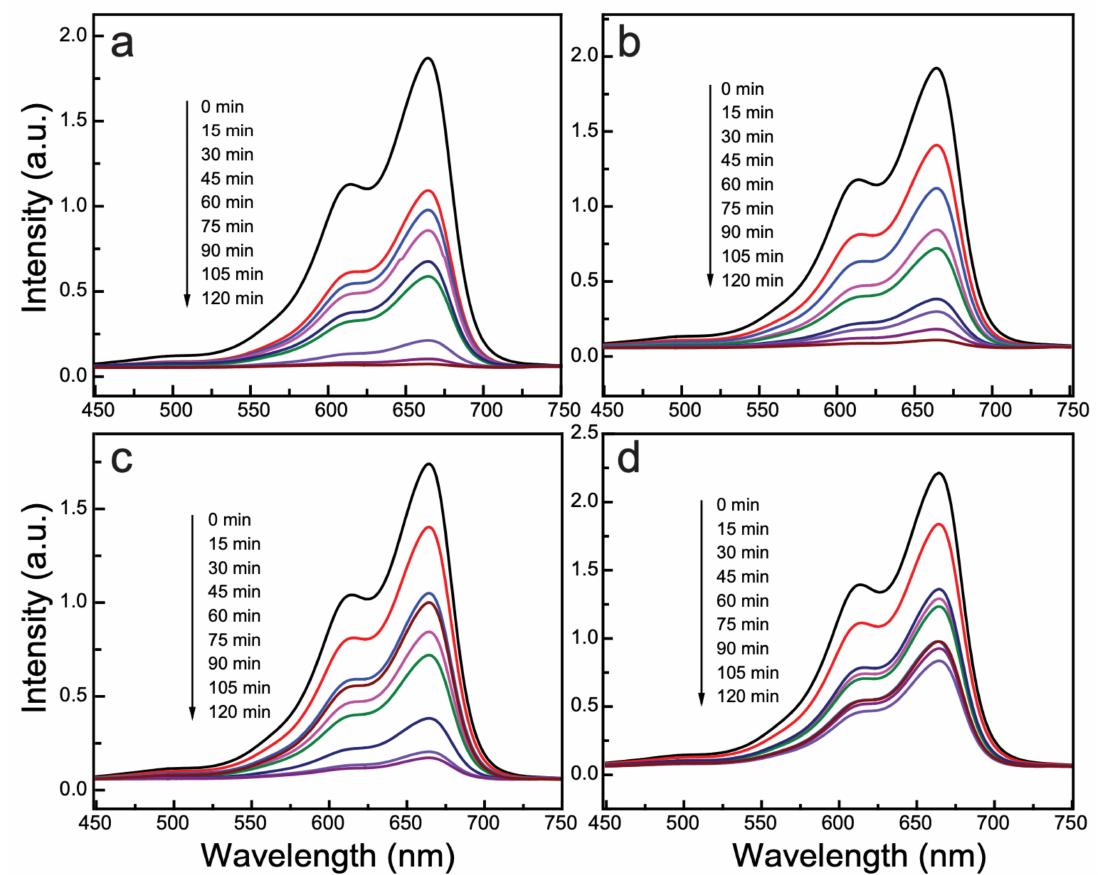
Figure 6. Photodegradation of the methylene blue (MB) solution varying with time of exposure, as examined by UV–vis absorbance spectroscopy: ( a ) CuOSC-3, ( b ) CuOSC-2, ( c ) CuOSC-1, and ( d ) pure